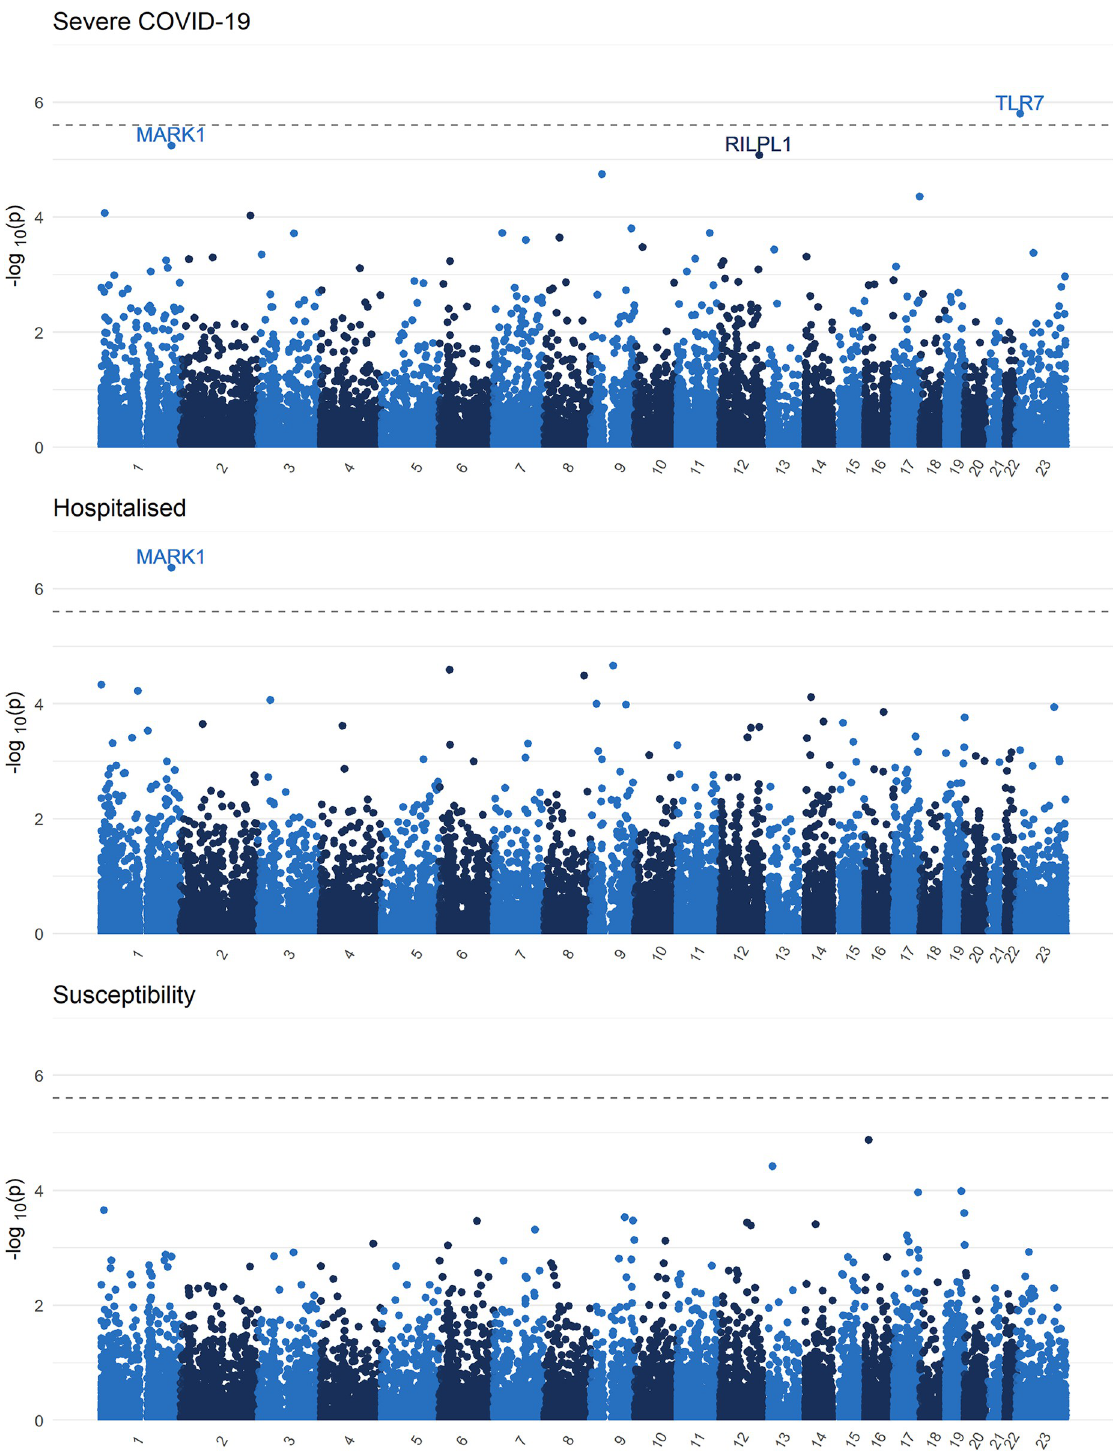
Fig 4. Exome burden test ACAT p-value meta-analysis Manhattan plots and QQ plots. QQ-plot available in the S6 Fig . Black dashed line demarcates the Bonferroni significance threshold (p < 0.5/20,000).